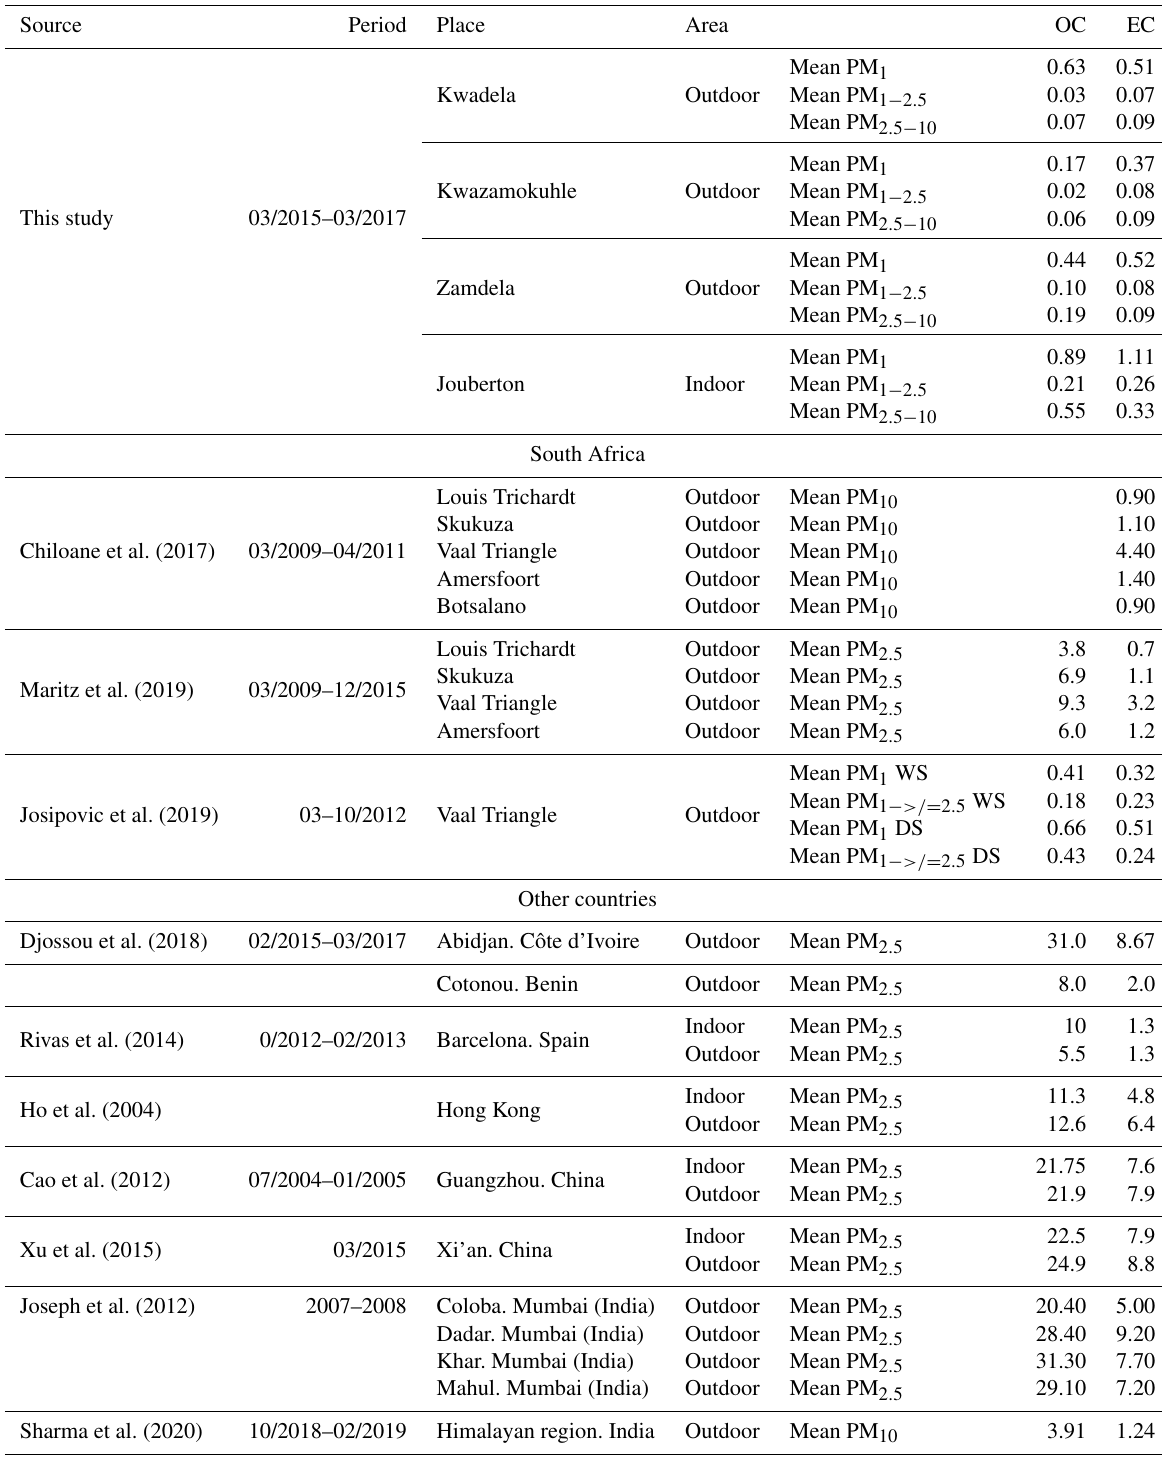
Table 5. Mean OC and EC concentrations (µgm − 3 ) determined at low-income settlements in this study and in other studies in South Africa and the rest of the